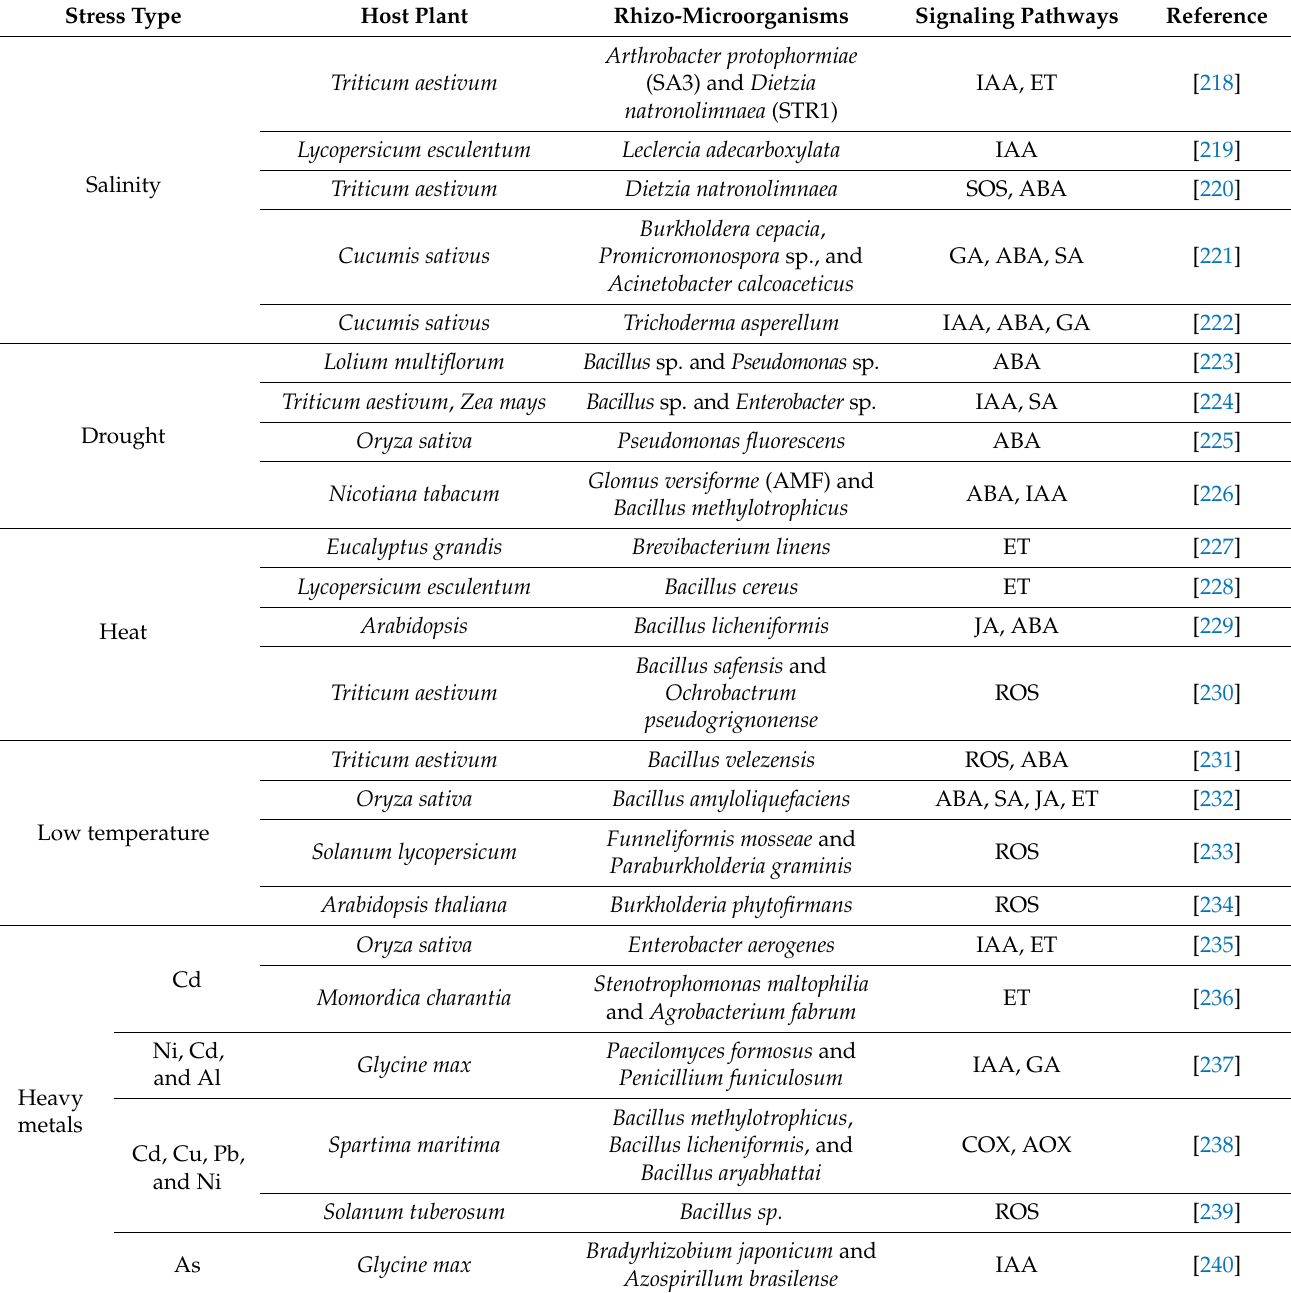
Table 2. Amelioration of abiotic stresses by rhizo-microorganisms using different signaling pathways in different plant